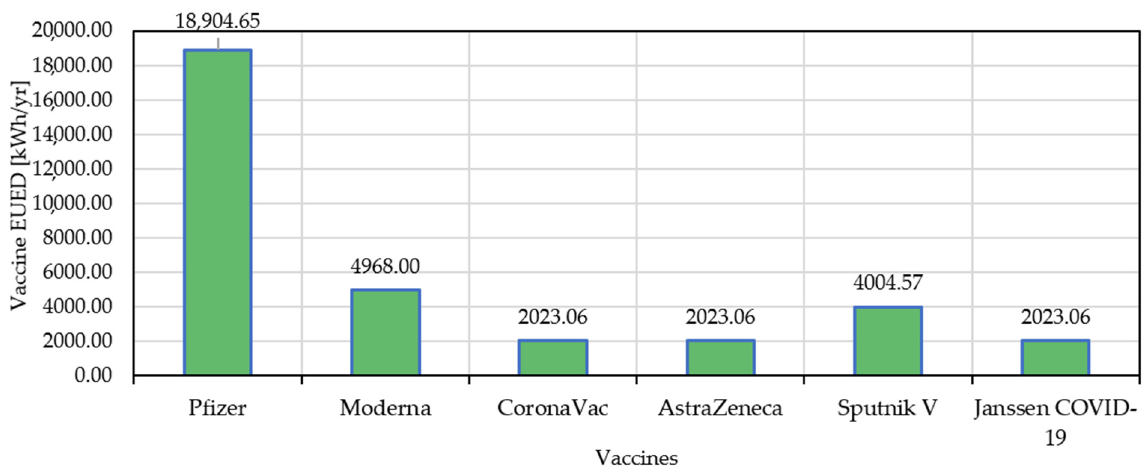
Figure 3. Vaccine Energy Usage Effectiveness Design (EUED) index.